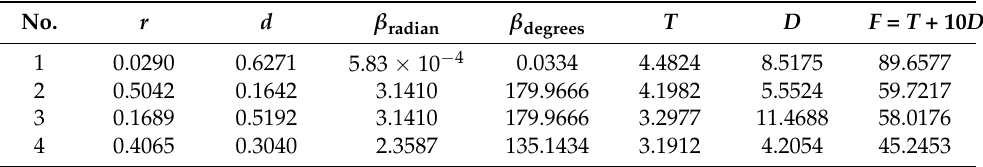
Table 3. Local maxima of the function F = T + 10 D .